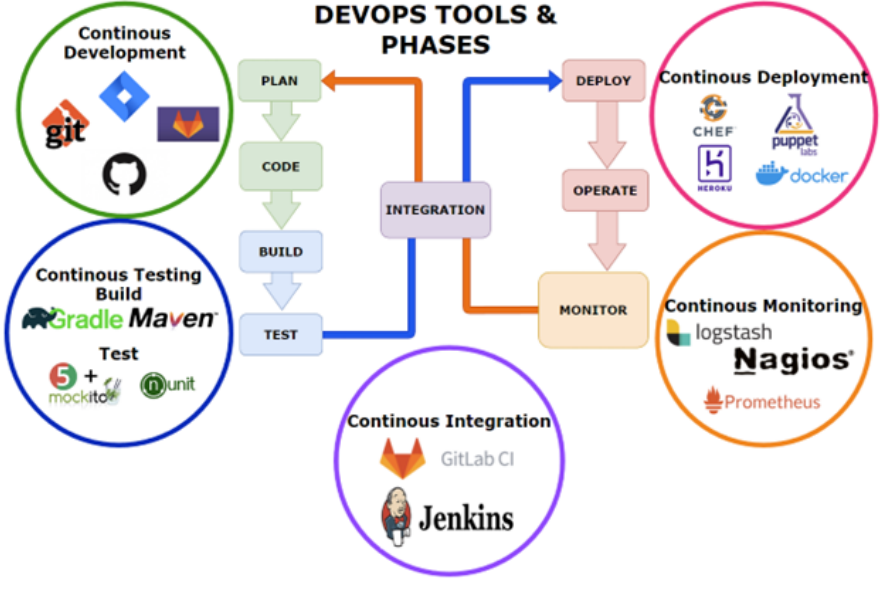
Figure 1. DevOps Tools and